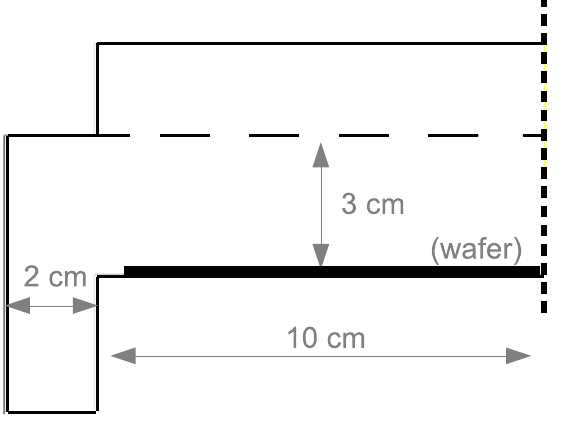
Figure 2. 2D axisymmetric PECVD